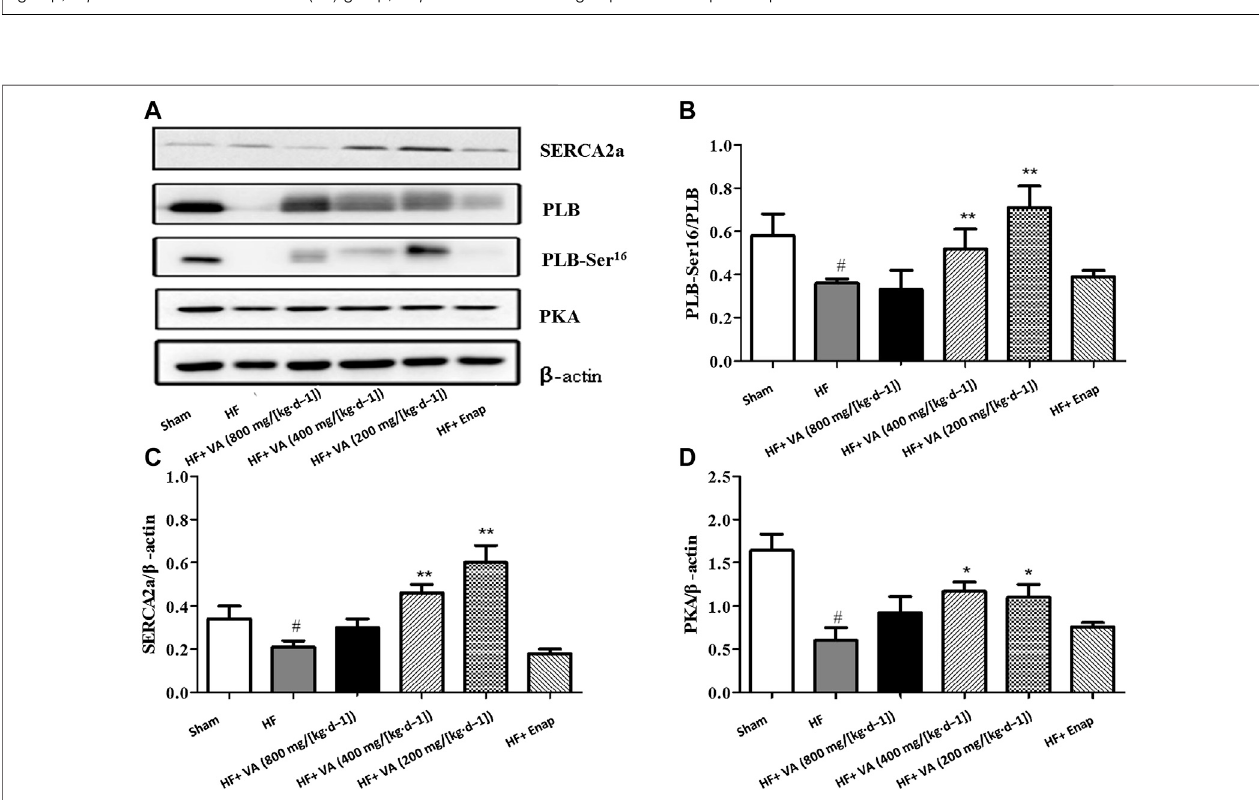
FIGURE 6 | The effect of velvet antlers (VA) on the protein expression of SERCA2a, PLB, PLB-Ser 16 , and PKA. (A) Representative western blot of each protein in the different groups. (B – D) Quantitative analysis of SERCA2a (B) , phosphorylated PLB (C) , and PKA (D) expression. The data are expressed as means ± SEM. #: p < 0.01 vs. the sham group; *: p < 0.05 vs. the heart failure (HF) group; **: p < 0.01 vs. the HF group. n (cid:1) 6. Enap: